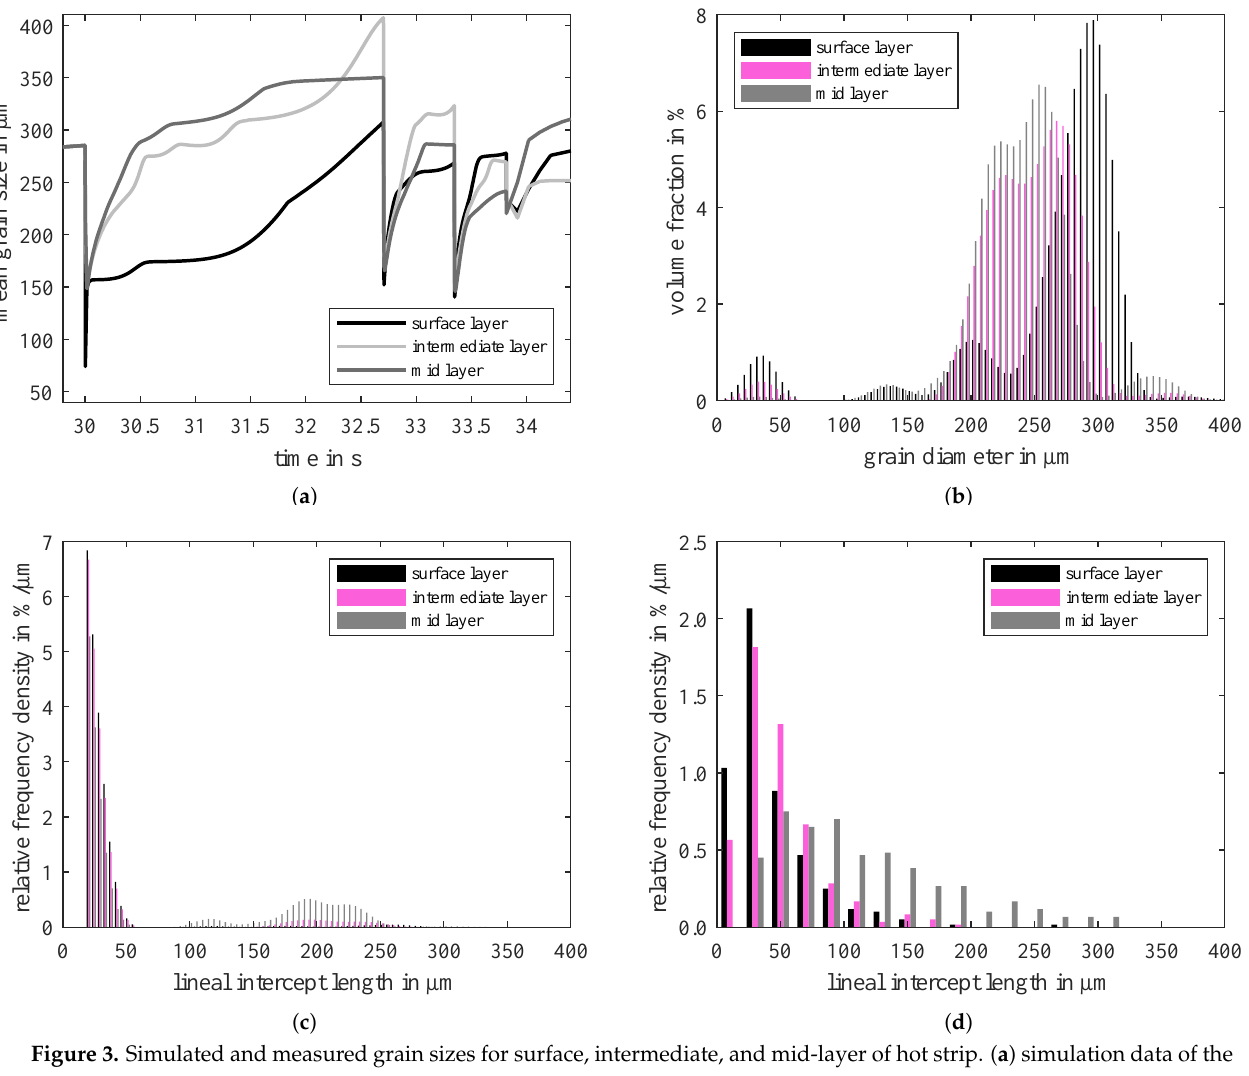
Figure 3. Simulated and measured grain sizes for surface, intermediate, and mid-layer of hot strip. ( a ) simulation data of the mean grain size evolution during hot rolling, ( b ) simulated grain size distribution after the last hot rolling pass, ( c ) simulated grain size distribution converted to relative frequency density and lineal intercept length, ( d ) grain size distribution of hot strip produced under laboratory conditions, grain size measured by lineal intercept method on the basis of 300